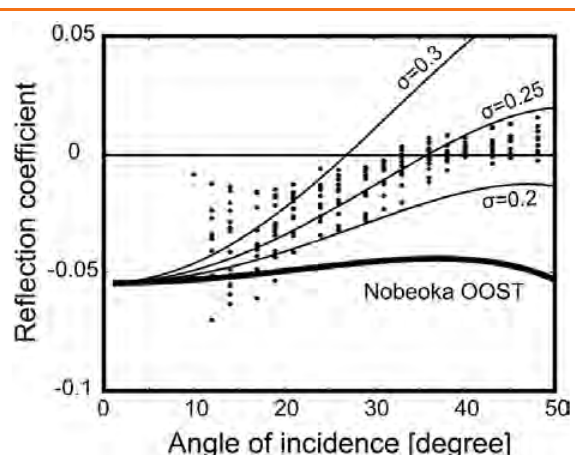
Figure 4. Comparison of angle-dependent reflection coefficients of discrete Nobeoka OOST samples (thick line) (Tsuji et al., 2006); the active Kumano OOST from seismic reflection data (solid dots) (Zone B in Tsuru et al., 2005). Thin lines represent reflection coefficients parameterized by Poisson’s ratio. Poisson’s ratios in the footwall of the Nobeoka OOST are lower than that of the active Kumano OOST, suggesting high fluid pressures in the footwall of the active Kumano